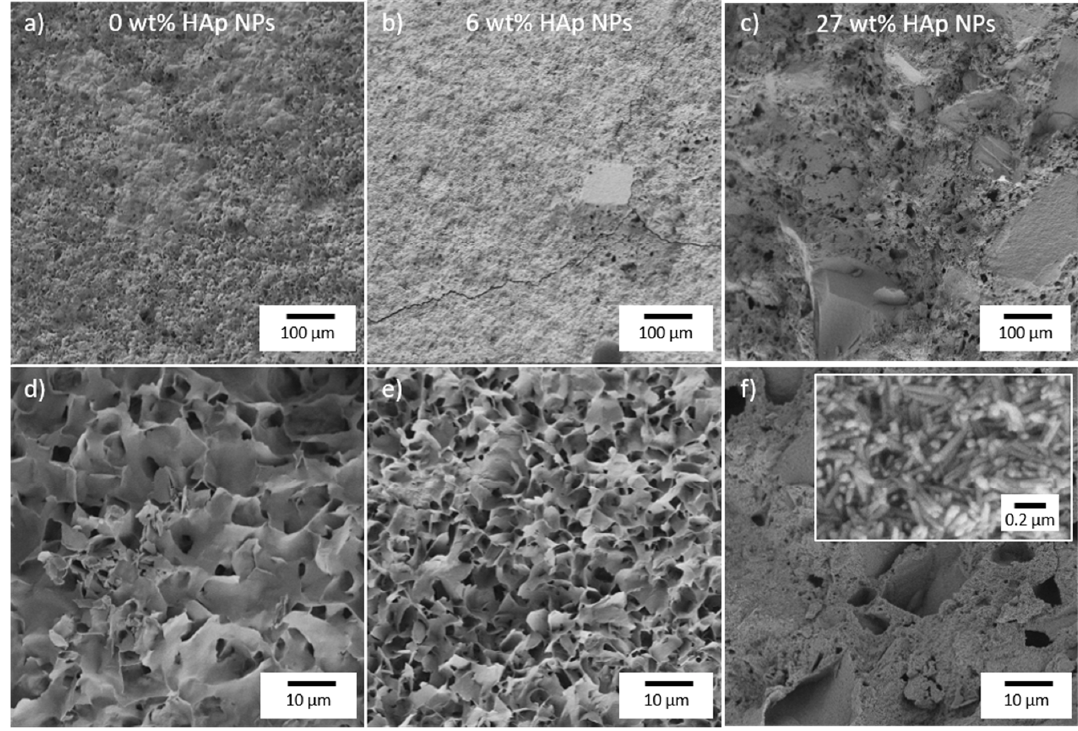
Figure 3. SEM micrographs of ( a ) , and ( d ) pure CPC, ( b ) and ( e ), CPC with a nanoparticle (NP) concentration of 6 wt%, and ( c ) and ( f ) CPC reinforced with 27 wt% HAp NPs.